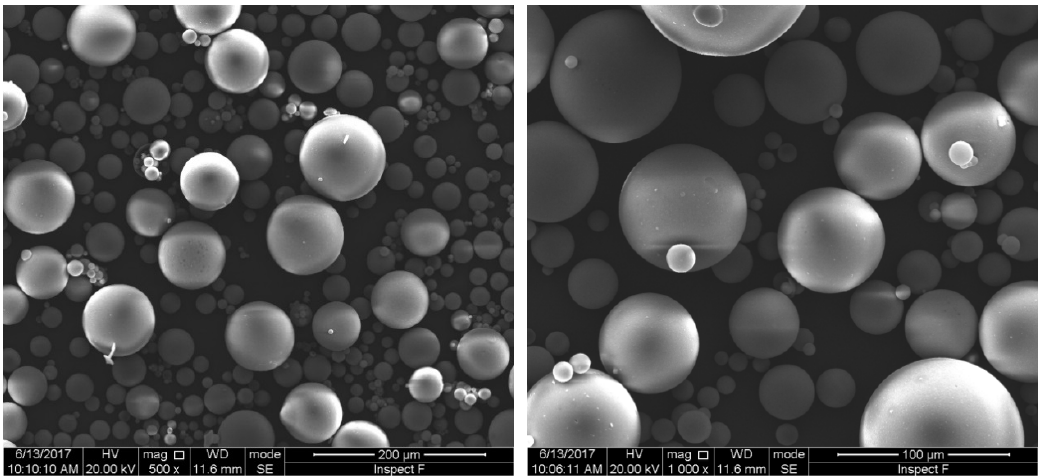
Figure 1. Scanning electron microscope (SEM) images of hollow glass microspheres.